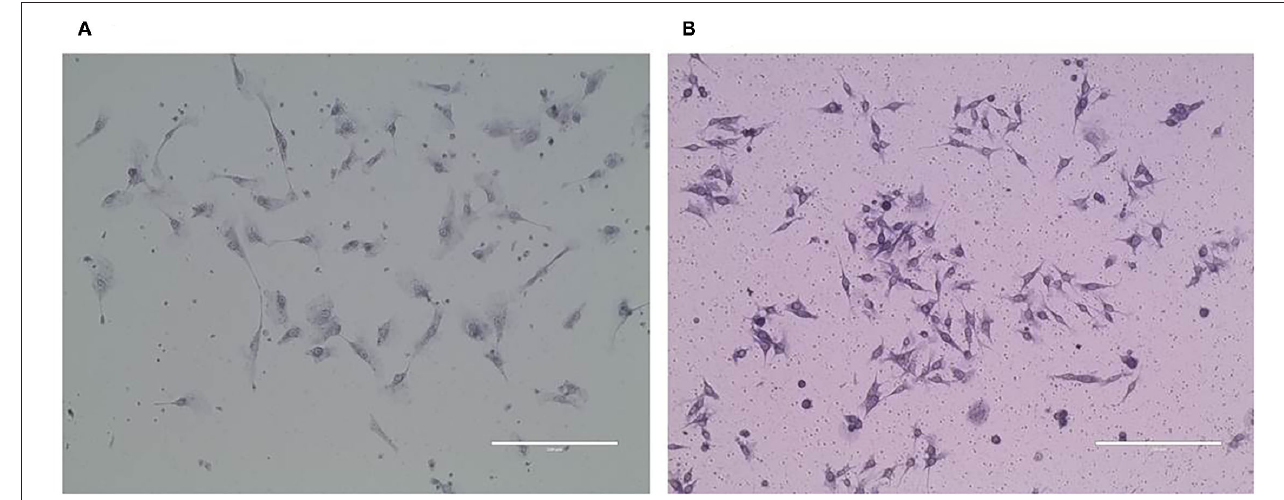
FIGURE 6 | Invasion ability of CMT-1026 (A) compared with U27 (B) with Transwell assays.